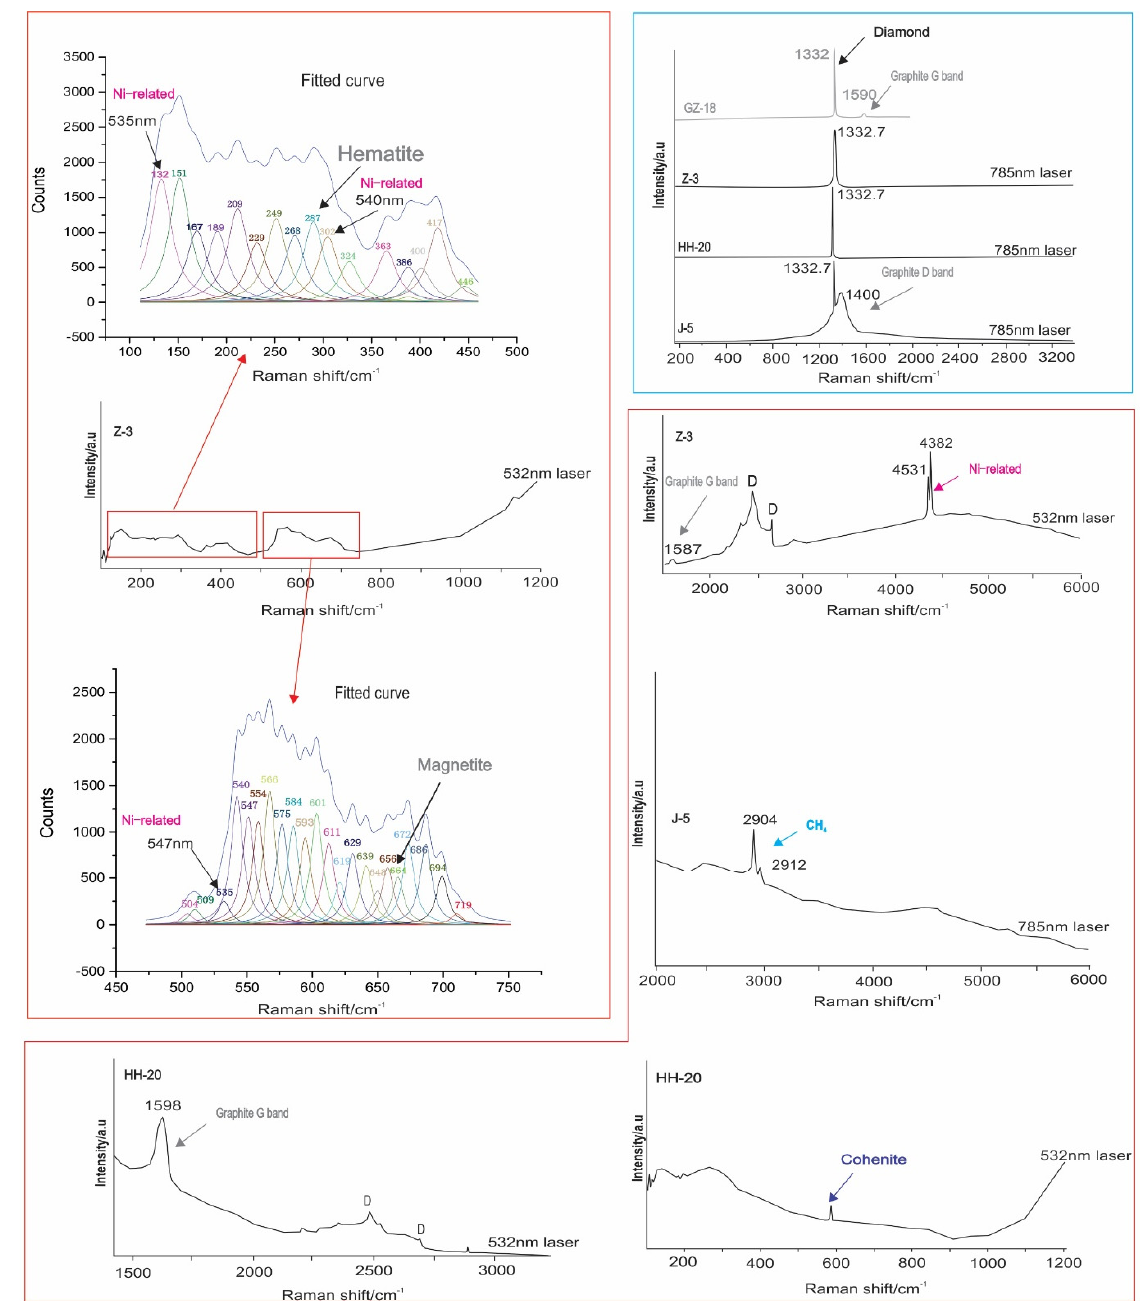
Figure 4. Raman spectroscopy of diamonds and inclusions in Chinese HPHT synthetic diamonds. The red frame: Raman Spectroscopy of inclusions in Chinese HPHT synthetic diamond. In sample Z-3, lichenoid inclusions demonstrated complex Raman and electron emission peaks; two red arrows point to the fit and division of the sample Z-3 original Raman lichenoid inclusions. The Cohenite in sample HH-20 are coated with graphite, which is often observed in our HPHT samples. Sample J-5 contains methane gas inclusions encircling metal alloys. Diamond Raman features are marked “D”. The blue frame: Raman spectroscopy of